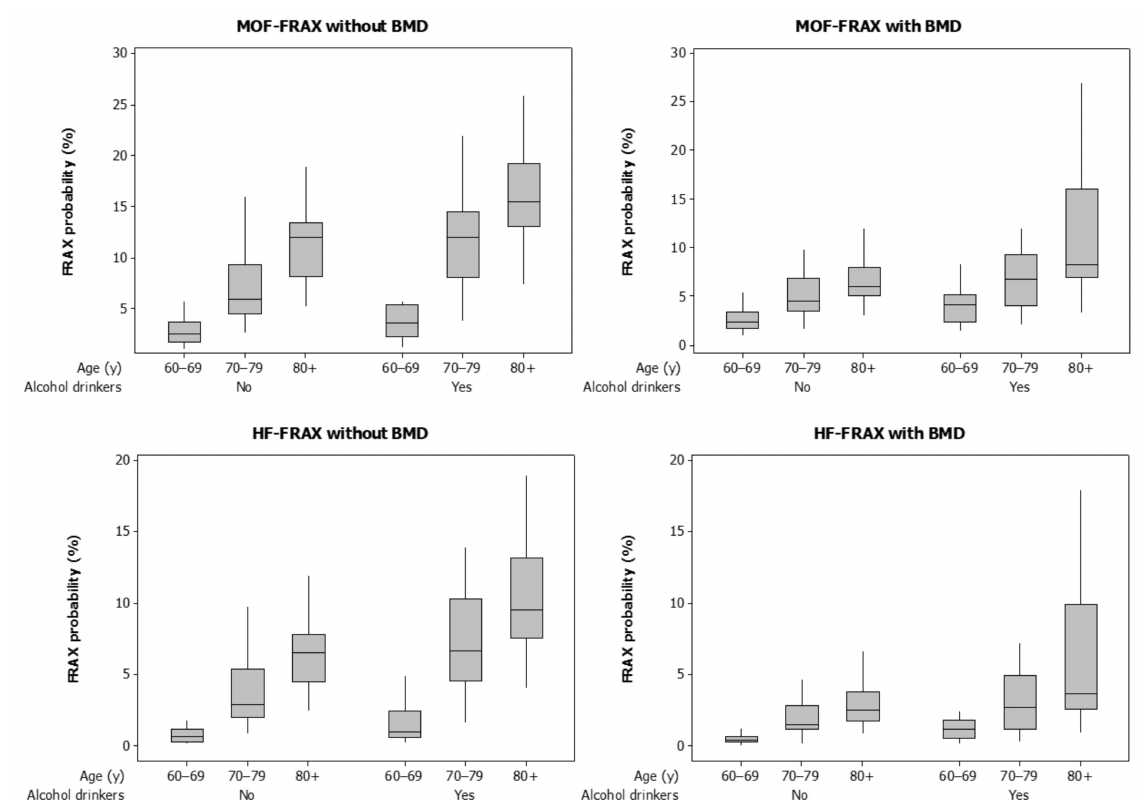
Figure 1. Boxplots for FRAX probabilities calculated with and without bone mineral density (BMD) for major osteoporotic fractures (MOF) and hip fractures (HF). Data are shown for alcohol drinkers (alcohol ≥ 3 units/d) and non-drinkers (alcohol < 3 units/d) and by age